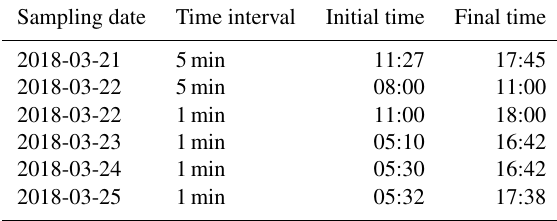
Table A1. Time windows with suitable images for analysis during the five sampling days surveyed with the